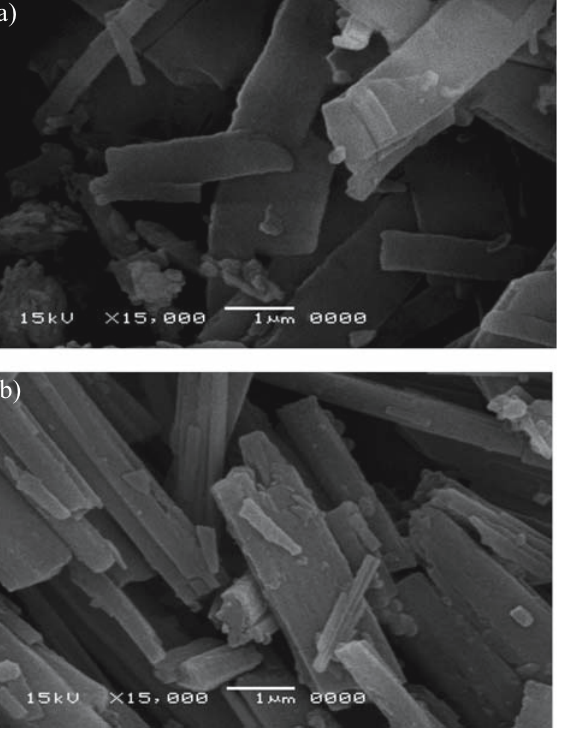
Figure 6: SEM micrographs of manganese ( II ) complexes ( a ) Mn - BHO; ( b ) Mn - BMO. morphology. Isolation of two complex structures ( Figure 5 ) is promoted from the acquisition of two SEM pictures with di ff erent morphologies ( Figure 6 ) . Clusters of larger size result from the aggregation of particles less than 100 nm in size.